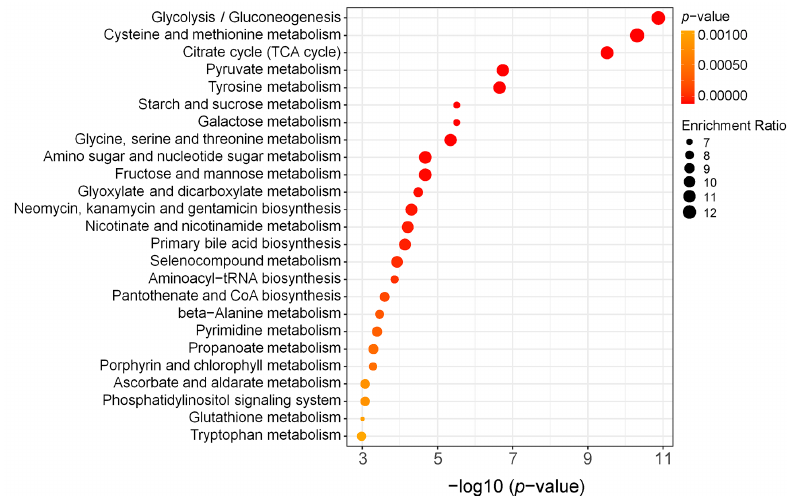
Figure 5. KEGG-enrichment analysis of differential metabolites. The top 25 metabolic pathways with the most significant differences were selected. The size of the dot represents the number of